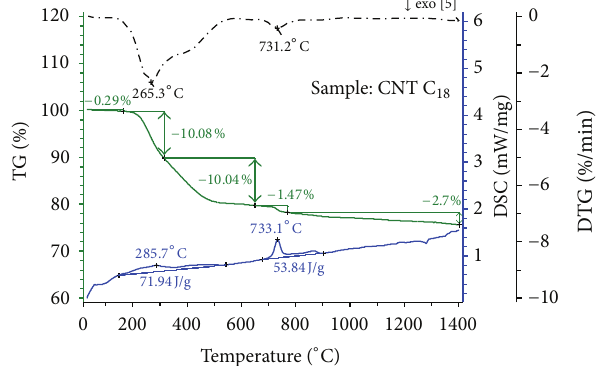
Figure 7: Temperature-dependent mass change (TG), rate of mass change (DTG), and heat flow rate (DSC) of the sample CNT-C 18 .